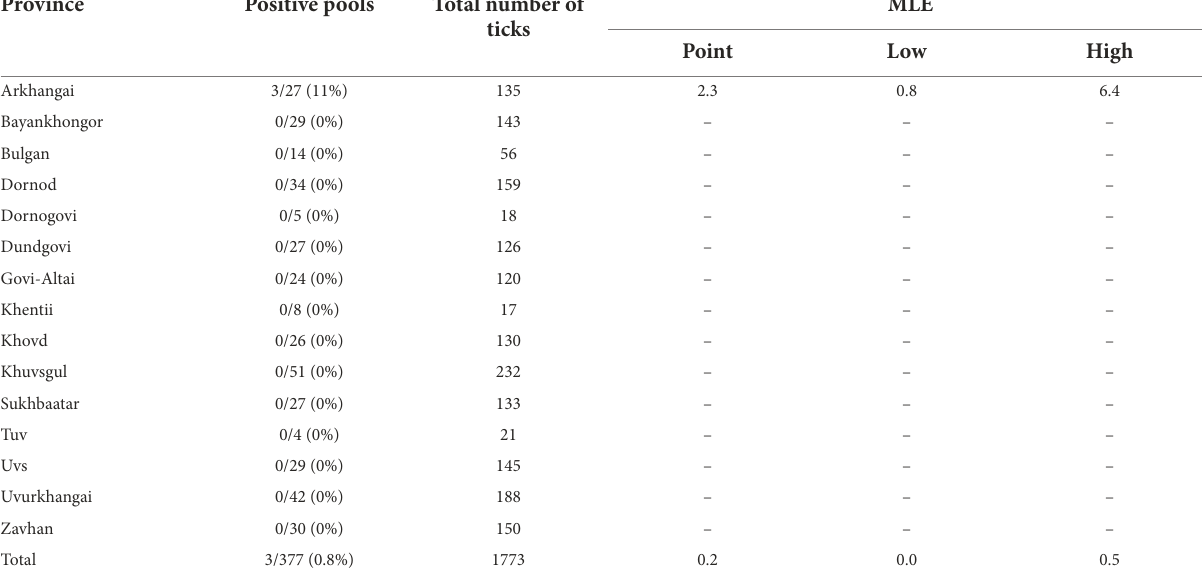
TABLE 5 Maximum likelihood estimates of Bartonella spp. by region based on confirmatory results including 95% confidence intervals. Bartonella